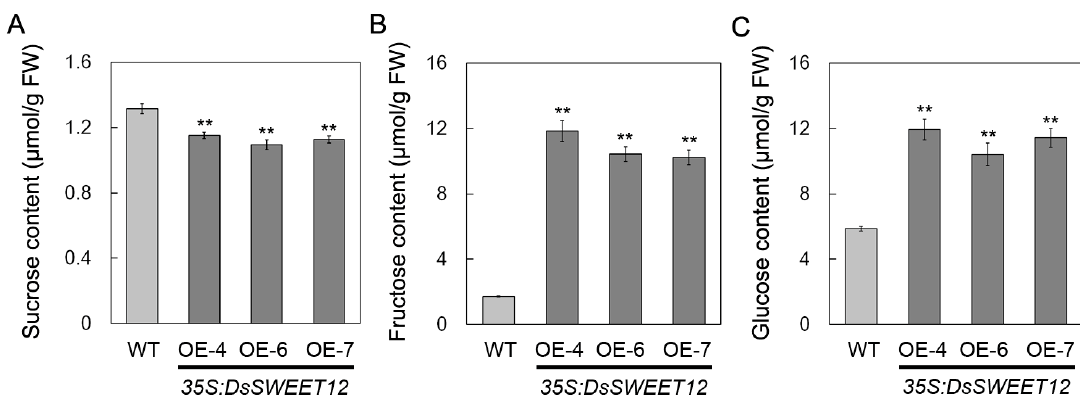
Figure 5. Sucrose ( A ), fructose ( B ), and glucose ( C ) content in wild type (WT) and DsSWEET12 transgenic Arabidopsis (OE-4, OE-6, and OE-7) seedlings. The sugar content was measured from seedlings grown on 1/2 MS (Murashige and Skoog; 3% sucrose) medium for 3 weeks. Asterisks indicate significant differences between WT and transgenic lines (** p < 0.01; Student’s t test). Error bars show SE of the values from three replicates.